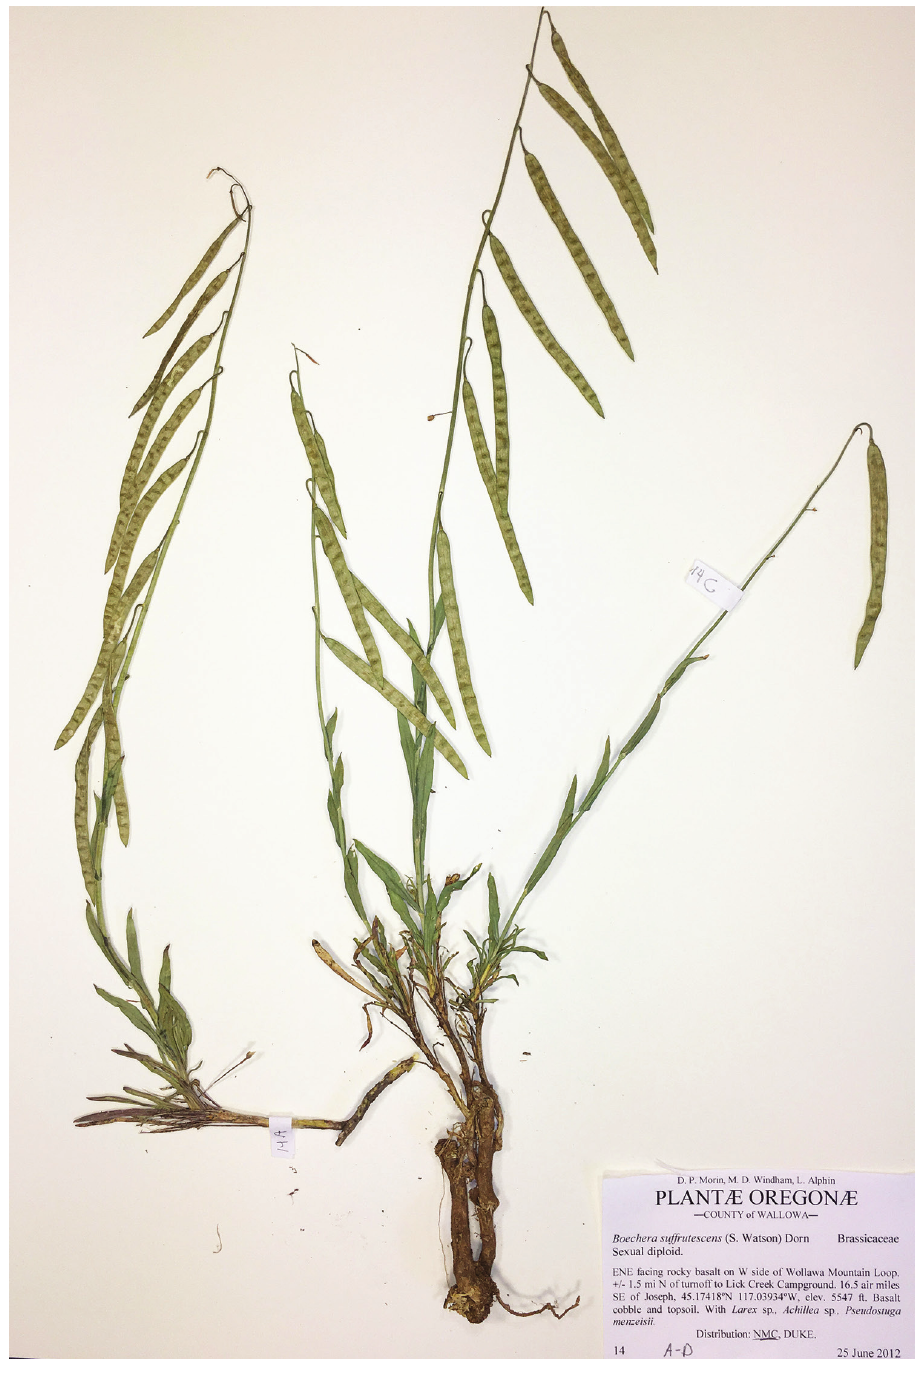
Figure 9. Boechera suffrutescens , Morin, Windham, Allphin 14